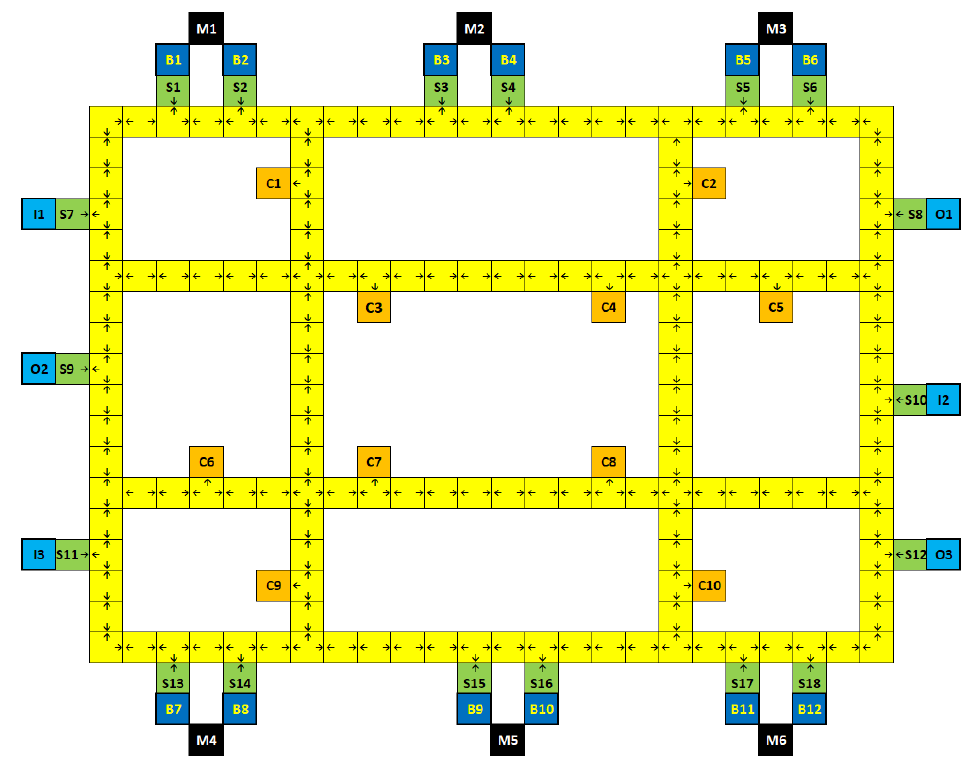
Figure 3. The layout with bidirectional flow